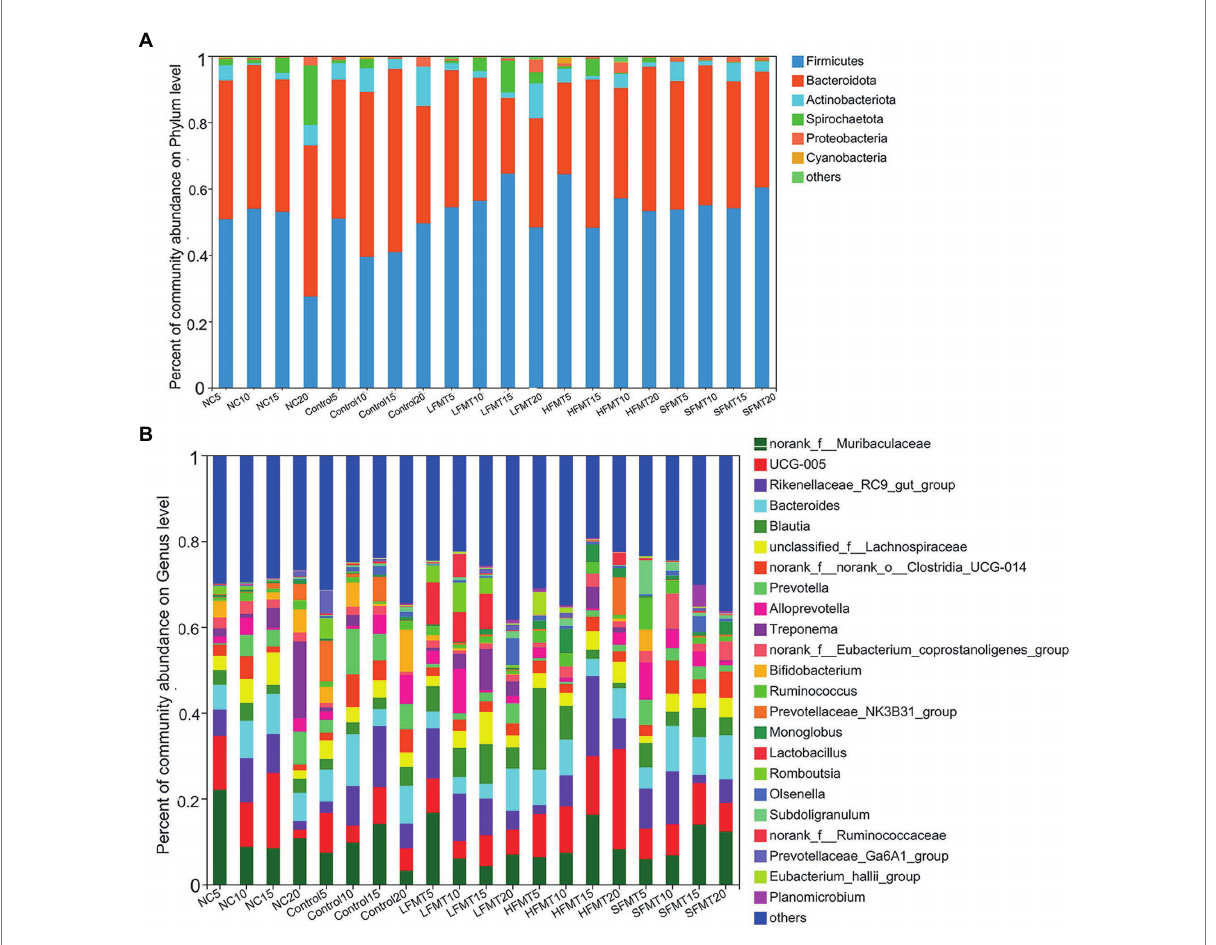
FIGURE 4 Comparison of fecal bacterial microbiota composition of FMT and untreated Holstein calves at four time points after weaning. (A) Flat relative abundance of bacterial microbiota in phylum level. (B) Relative abundance of bacterial microbiota composition at the genus